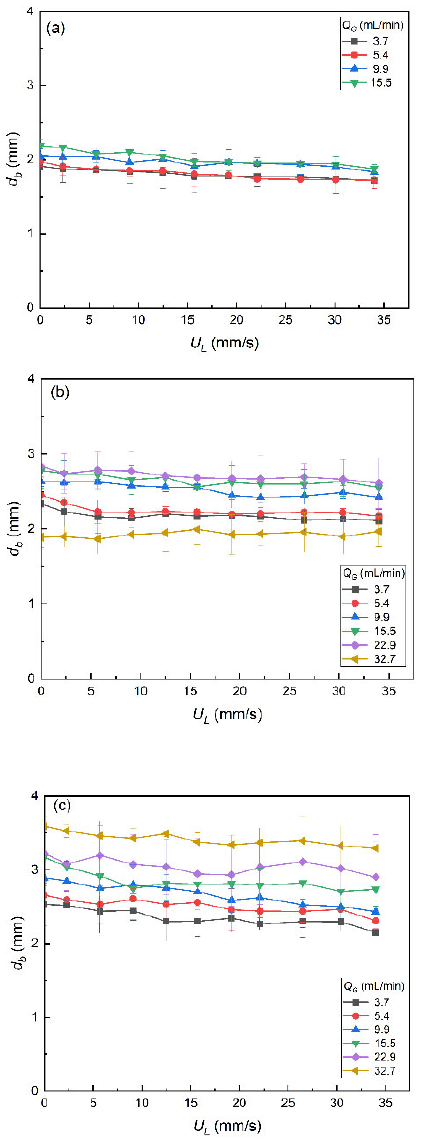
Figure 5. The mean bubbles’ size for different capillary sizes of ( a ) d G = 50 μ m, ( b ) d G = 100 μ m, ( c ) ( c ) d G = 50 µ m as a function of liquid velocity, U L and gas flowrates, Q G d G = 50 μ m as a function of liquid velocity, U L and gas flowrates, Q G .